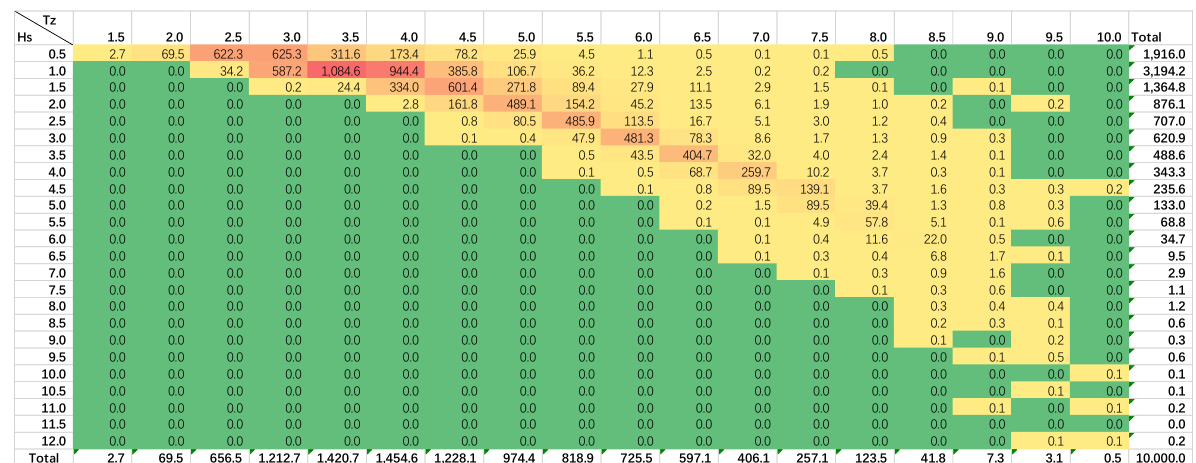
Figure 17. Wave scatter diagram at Site D. Figure 18. Wave scatter diagram at Site E. Figure 19. Wave scatter diagram at Site F. Figure 20 shows rose plots of the Hs and mean wave direction for the characteristic sites. It can be seen that the main wave directions at the three characteristic sites of the